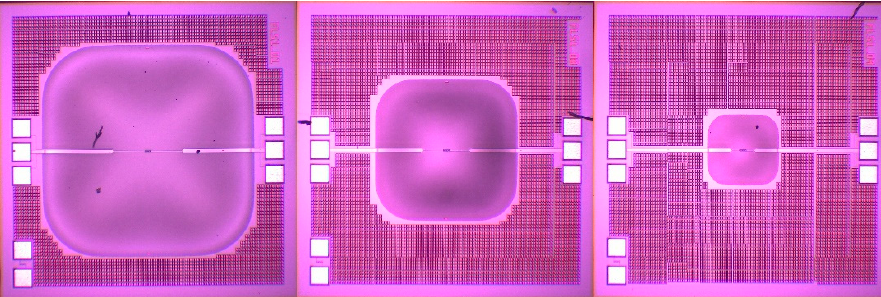
Figure 2. Microscope picture of the three devices analysed in this work, with membrane size of (from left to right) 1200 µm, 800 µm and 400